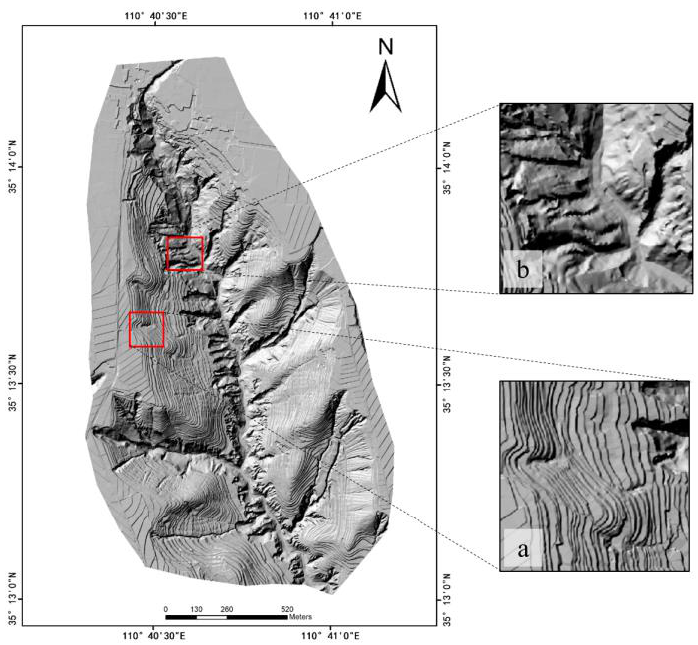
Figure 9. DEM based hillshade map of a small watershed in the Loess Plateau of China. ( a ) terraced field; ( b ) gully bottom area.